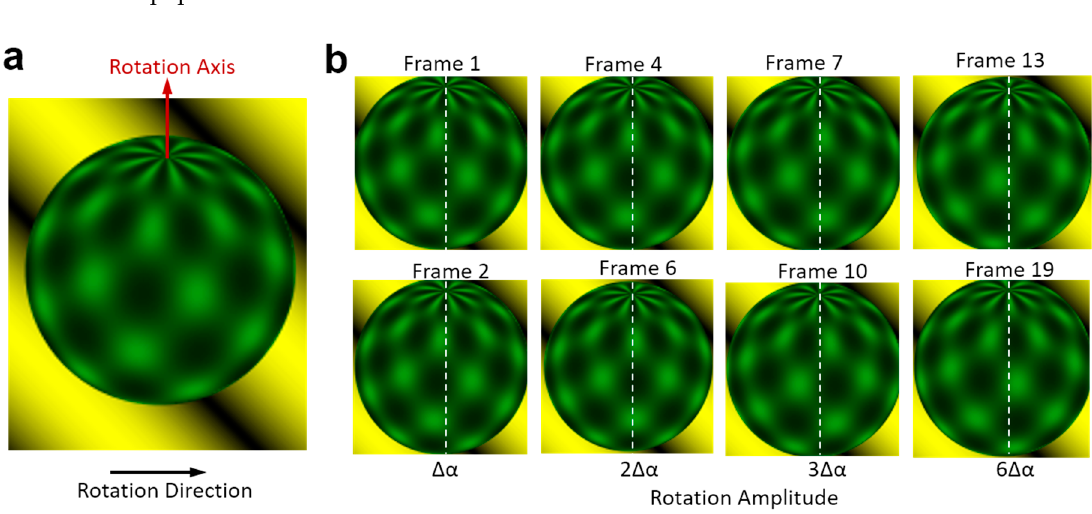
Figure 6. Baker’s test template. ( a ) An artificial ball rotates around an axis in the anti-clockwise direction looking in a top view; and ( b ) the image sequence of the region of interest. ∆α represents the angle between two adjacent images. The white dash line is the benchmarking for convenient comparison.